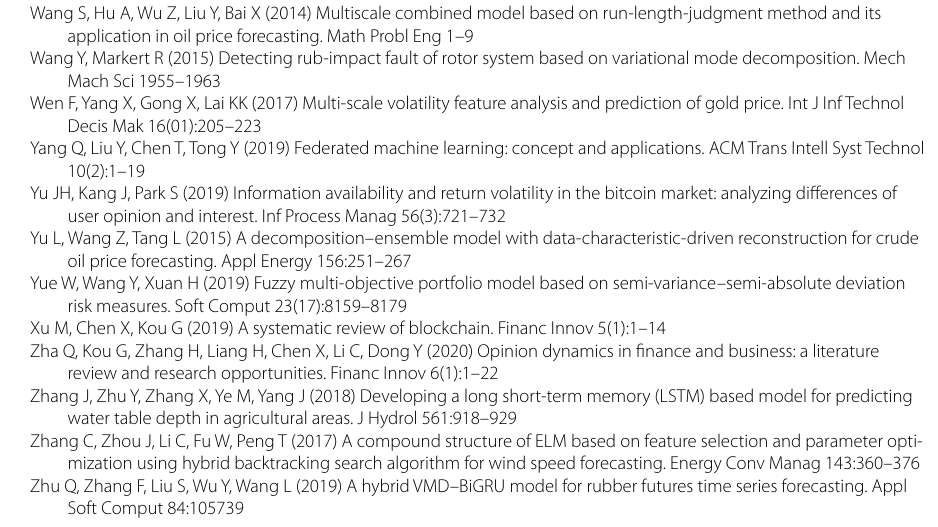
water table depth in agricultural areas. J Hydrol 561:918–929 Zhang C, Zhou J, Li C, Fu W, Peng T (2017) A compound structure of ELM based on feature selection and parameter